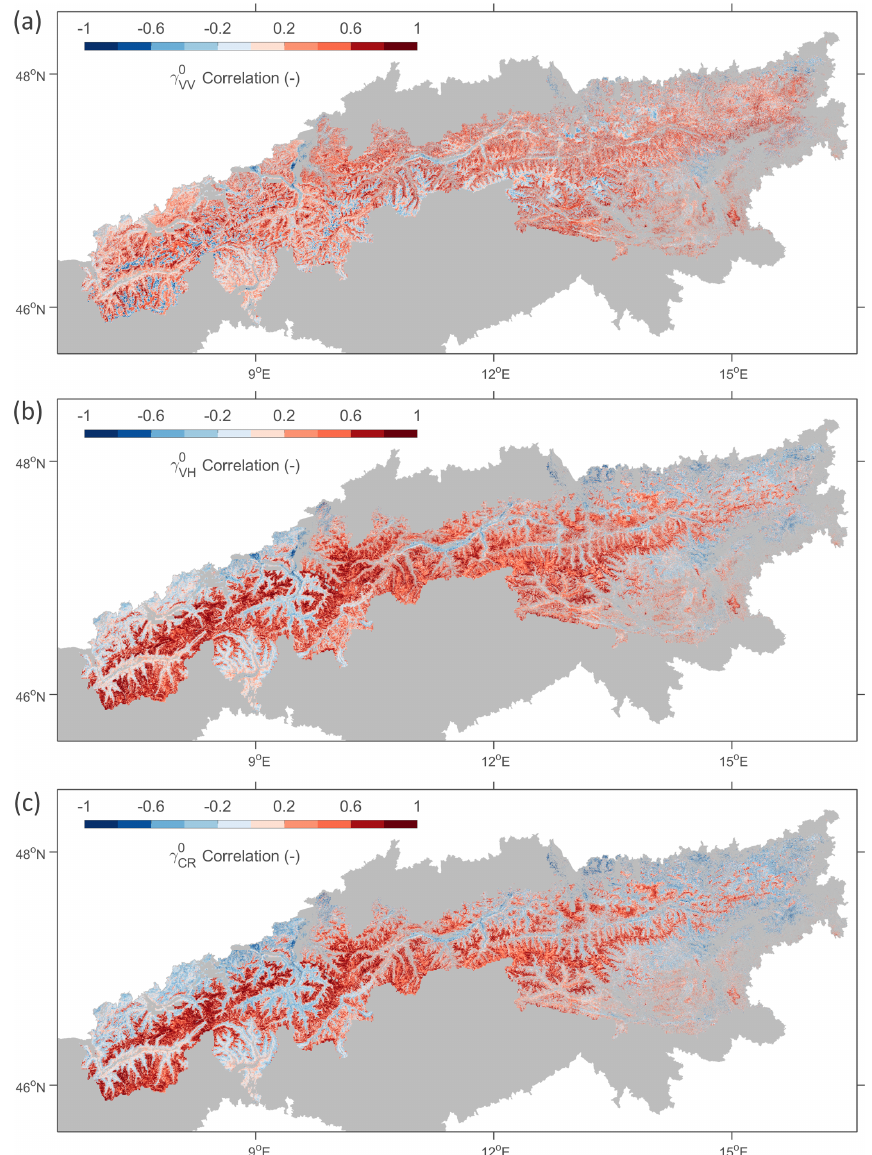
Figure 6. The time series correlations between snow depth simulations (m) and 100m S1 γ 0 observations (dB) for August through April 2017–2018 and 2018–2019, for (a) VV polarization, (b) VH polarization, and (c) the cross-polarization ratio (CR). Zero snow depths (based on the model simulations) and wet snow conditions (detected by S1) are